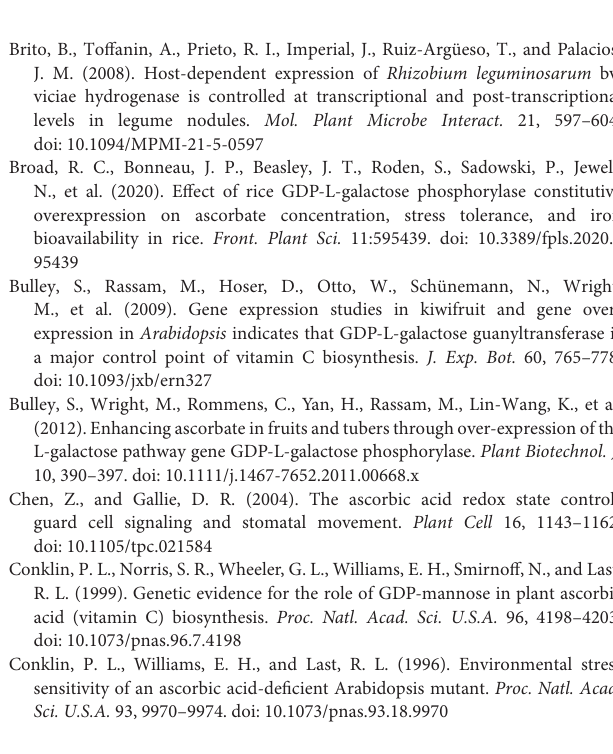
Supplementary Figure 1 | Relative expression of MtVTC2 in nodules of the empty vector (EV) and oxVTC2 lines measured by qPCR using the reference gene PTB (Kakar et al., 2008) for normalization. Values represent the average ± SD fold-change of relative expression in the oxVTC2 lines compared to the EV plants calculated using the 2 − 11 Cq method ( Livak and Schmittgen, 2001) ( n = 6, three biological and two technical replicates). Supplementary Figure 2 | Representative images of M. truncatula root nodule sections of the empty vector (EV, A,B ) and oxVTC2 lines (C,D) after staining for the detection of superoxide using nitrobluetetrazolium (A,C) or H 2 O 2 using 3,3 ′ -diaminobenzidine-HCl (B,D) . Scale bars represent 500 µ m. Supplementary Figure 3 | Levels of sucrose in nodules of M. truncatula empty vector (EV) and oxVTC2 plants under well-watered control (C), mild drought (MD), and severe drought (SD) conditions. Values represent the average ± SE ( n = 5 biological replicates). Mean values represented by the same letter do not differ statistically ( p ≤ 0.05 ANOVA test). NDW, nodule dry weight. Supplementary Table 1 | List of primers for used for qPCR